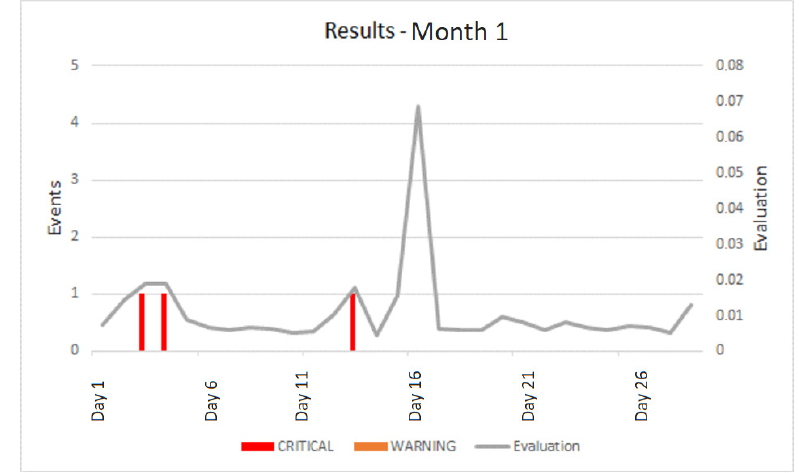
Figure 8. Aggregated evaluation graph and relevant events (production scenario—month